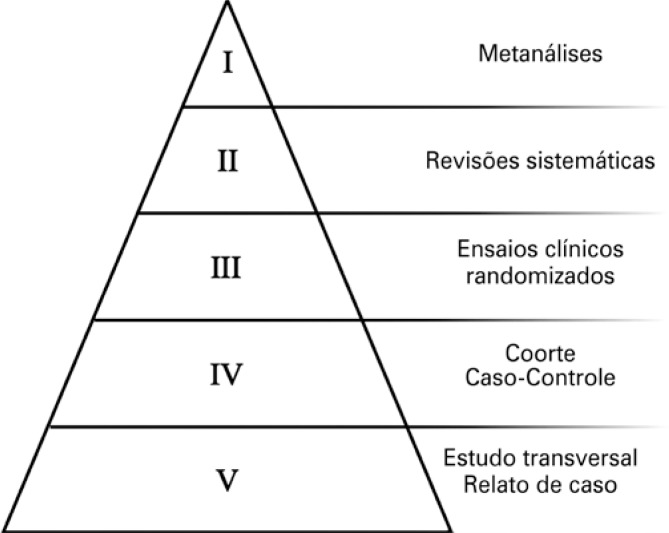
A pirâmide de nível de evidência nas ciências médicas